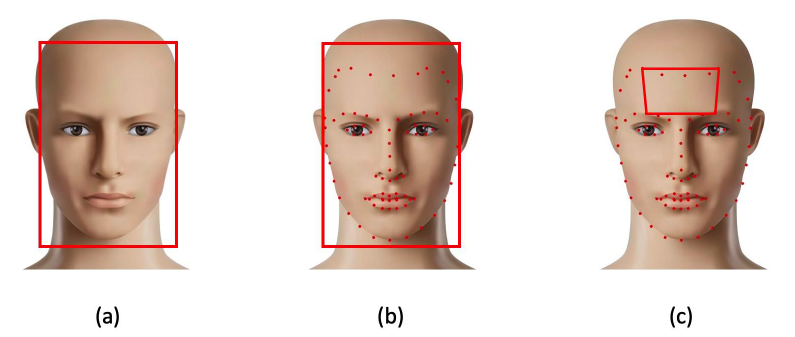
Figure 5. ( a ) Output of face detection step; ( b ) identification within the face of 81 landmarks (red dots); ( c ) ROI selection for rPPG signal extraction (the forehead) using a subset of the